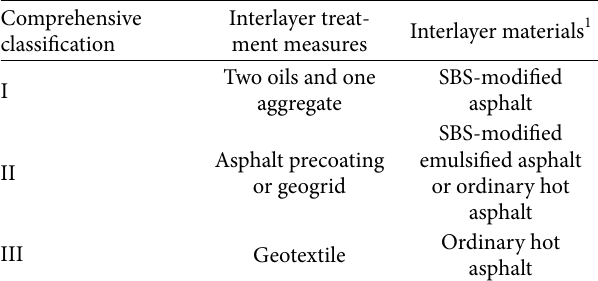
Table 16: Grading treatment scheme under different comprehensive working